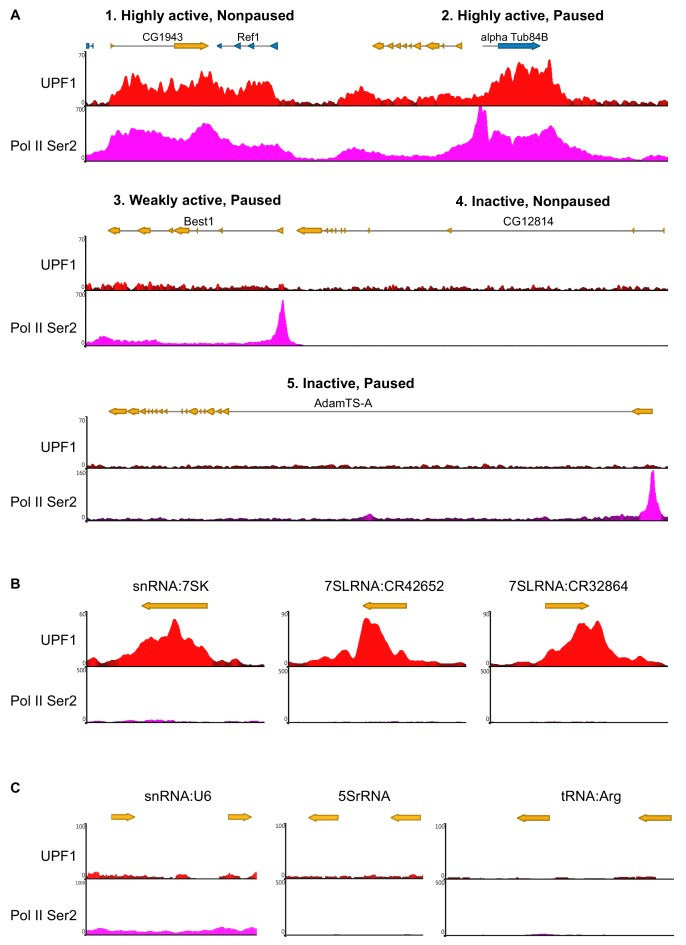
ChIP-seq profiles of UPF1 at representative Pol II genes and some Pol III loci.(A) ChIP-seq profiles of UPF1 (red) and Ser2 Pol II (pink) at different active genes characterised by either paused or not paused Pol II at the TSS (panels 1–3). Panels 4 and 5 show absence of Upf1 at two inactive genes, with or without paused Pol II. (B) ChIP-seq profile of UPF1 (red) and Ser2 Pol II (pink) at the three Pol III transcribing gene loci indicated. (C) ChIP-seq profiles showing no UPF1 signal at three highly transcribing Pol III genes (snRNPU6, 5SrRNA and tRNA:Arg).